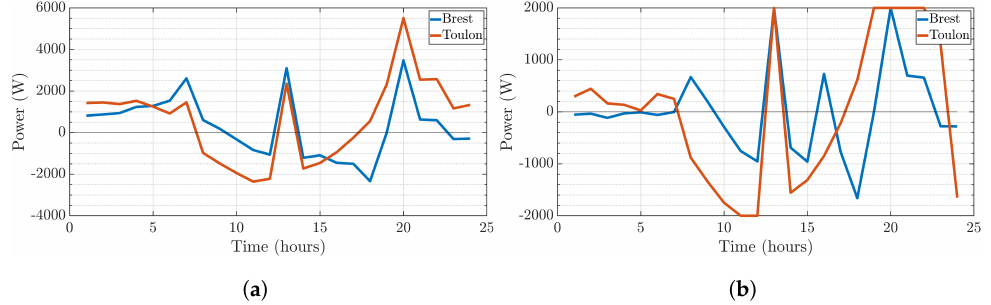
Figure 7. Case study 1: Net power and battery power for Brest and Toulon. ( a ) Net power highlighting production/consumption unbalance during the day. ( b ) Battery power for 24 h.